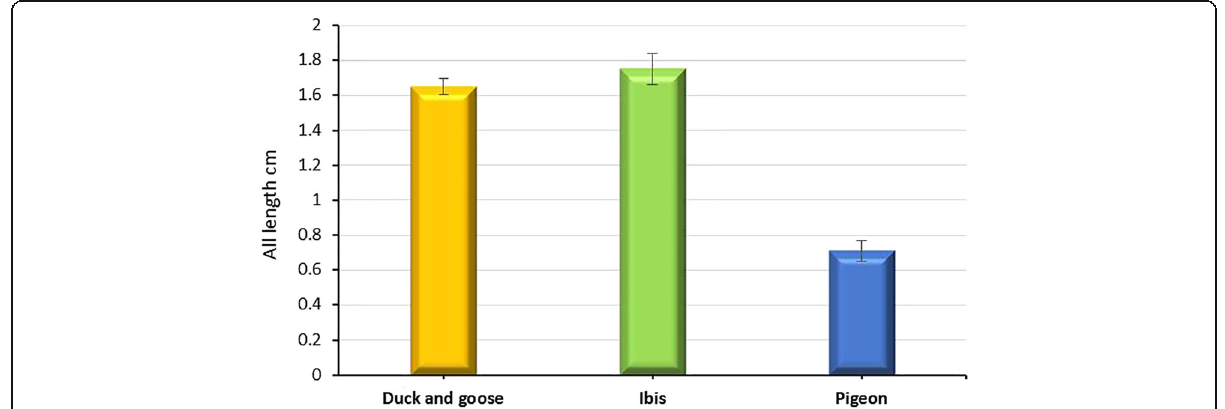
Fig. 4 Descriptive statistics of mean ± SD of whole length of HG in adult duck, goose, ibis, and pigeon